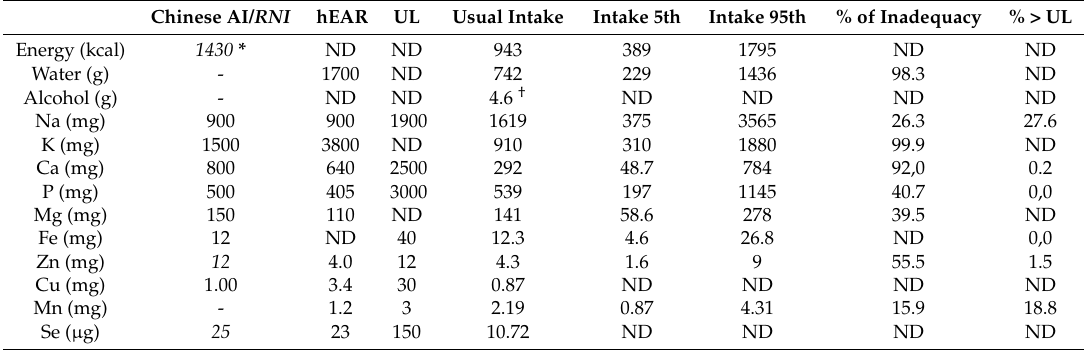
Table 4. Chinese DRIs (China CDC, 2009), hEARs, ULs, usual intakes, and risks of inadequate intakes of the rural Tibetan children ( n = 250, mean for: age = 4.4 y.; weight = 14.9 kg; height = 99 cm). Chinese AI/ RNI hEAR UL Usual Intake Intake 5th % >